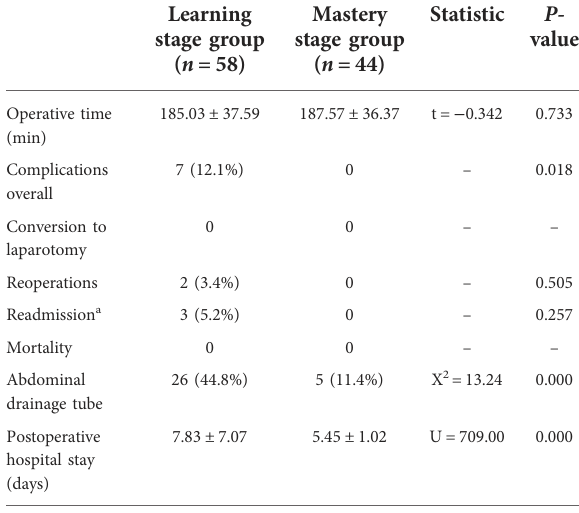
TABLE 3 Comparison of the operation-related outcomes between the 2 study groups. TABLE 2 Comparison of the demographics between the 2 study